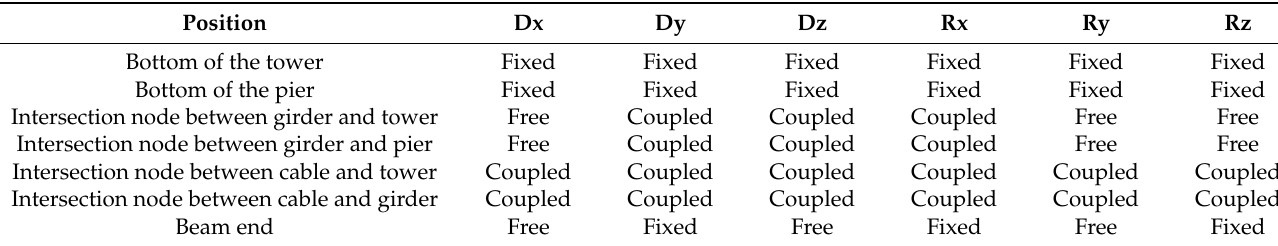
Figure 9. Standard finite element model of Nanxi River Bridge.